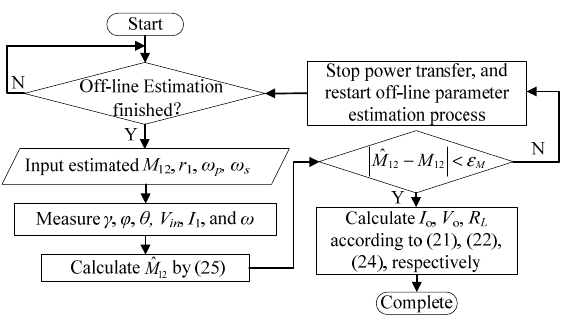
Figure 5. Flowchart of the off-line parameter estimation.